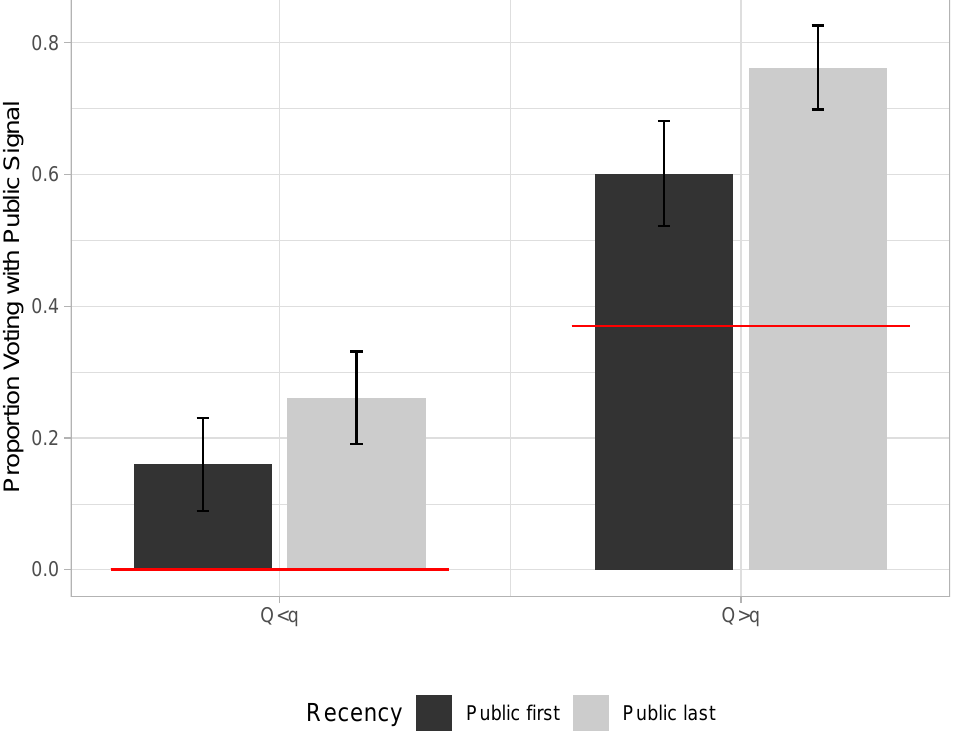
Figure 4. Recency effect : Average fraction of votes with public signal under mismatch, and 95% confidence intervals. Standard errors are clustered at the individual level. Dark columns correspond to rounds where the public signal is displayed first. Horizontal lines represent symmetric responsive equilibrium predictions for µ